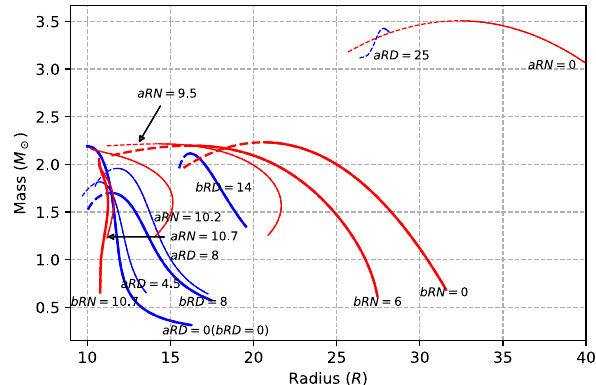
Fig. 2 Mass–radius relations for three representative neutron EoS: SLy4, APR4 and SKb. The aqua line indicates the multimessenger con- straints from the results of [58] on the radii of neutron stars of 1.4 M (cid:2)